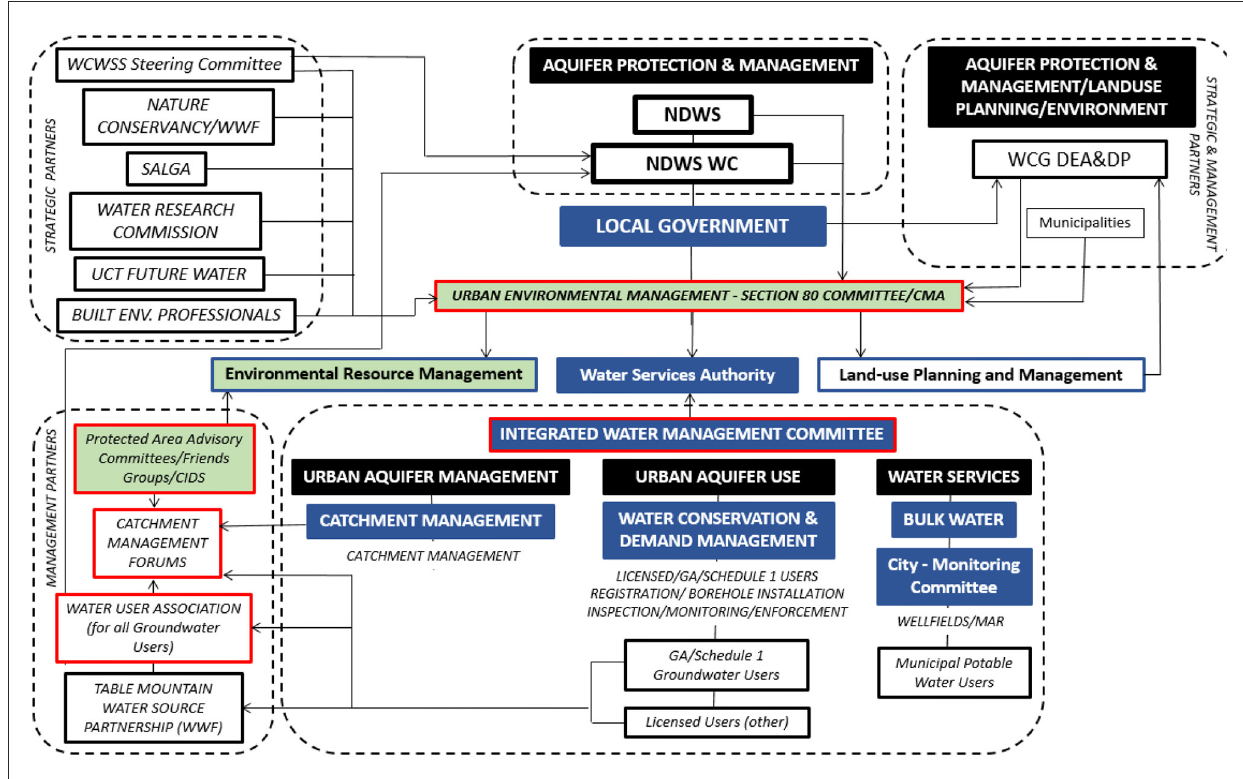
FIGURE6 Proposed institutional arrangements; Source: Faragher